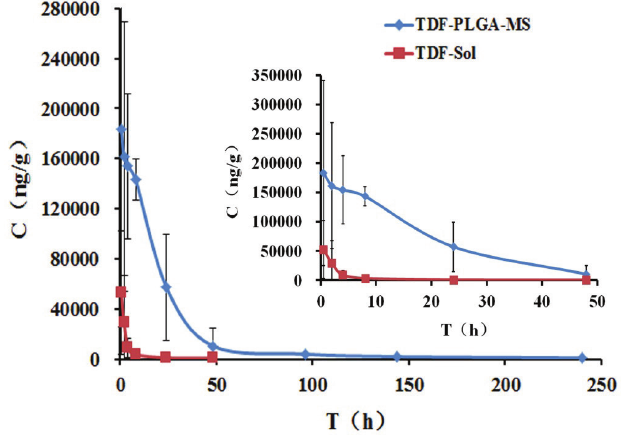
FIGURE 9 - Mean residual concentration–time curves of TDF in lung after intratracheal instillation of TDF -Sol and TDF-